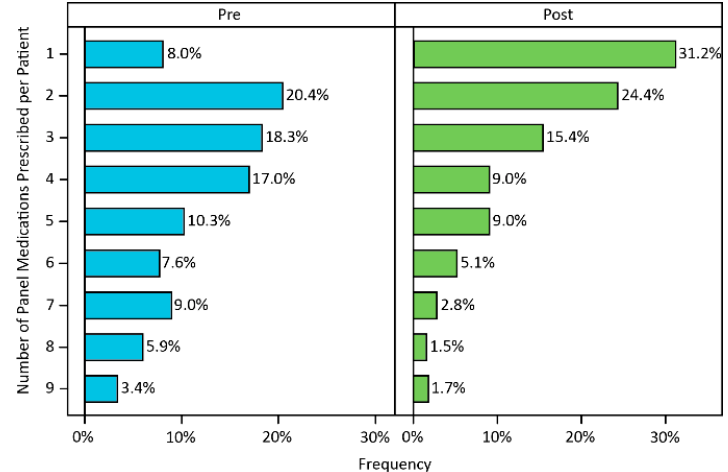
Figure 3. Number of prescribed psychotropic medications pre- and post-PGx testing. Prior to PGx testing, a majority of patients were taking four or more psychotropic medications, whereas, post-PGx testing, this number dropped to a majority taking two or fewer psychotropic medications.